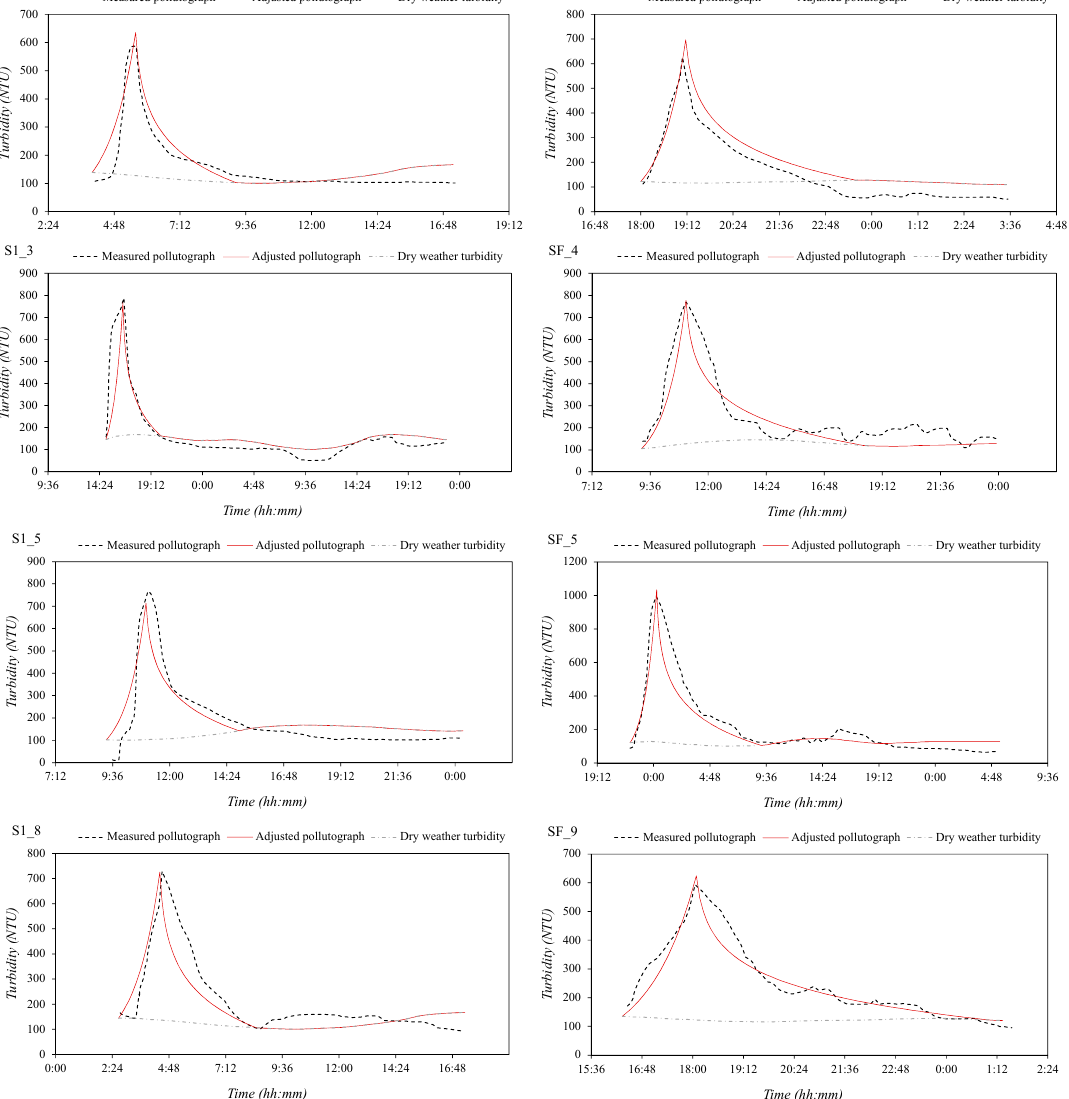
Figure 9. Comparison between measured pollutographs and calculated ones through the suggested methodology.